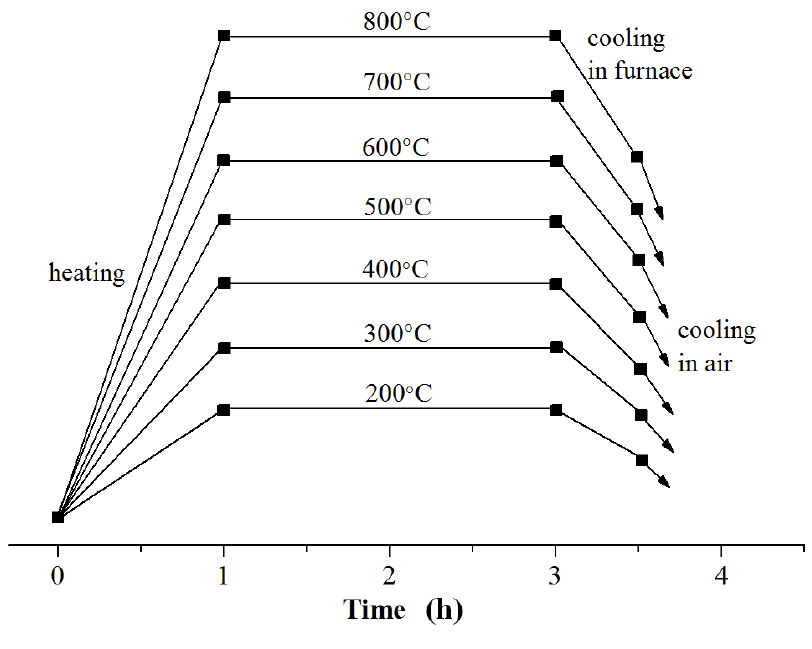
Figure 2. Coating annealing